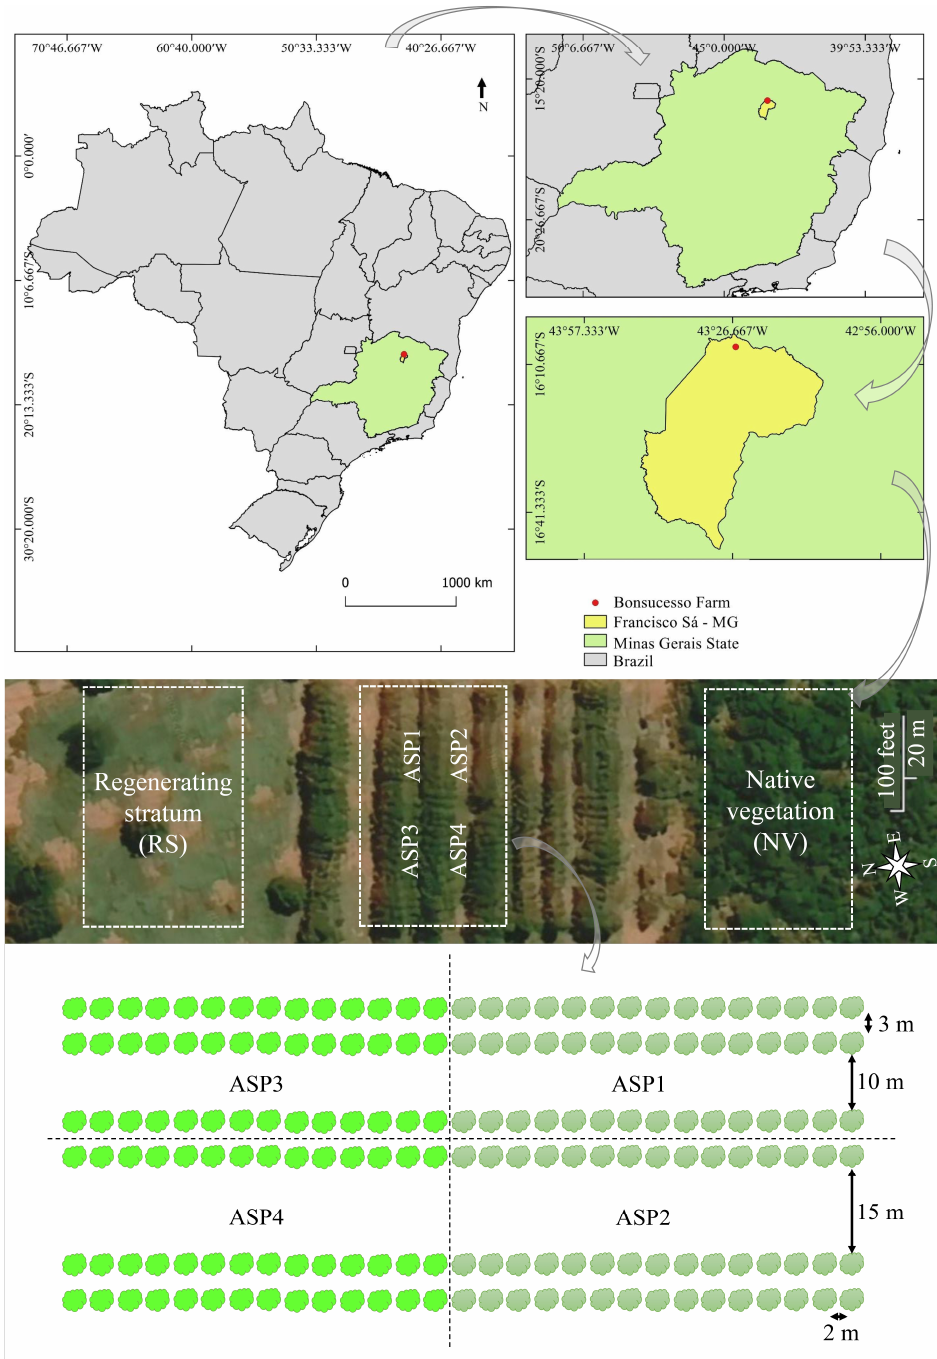
Figure 1. Location of the study area and schematic representation of agrosilvopastoral systems in the municipality of Francisco S á , Minas Gerais,